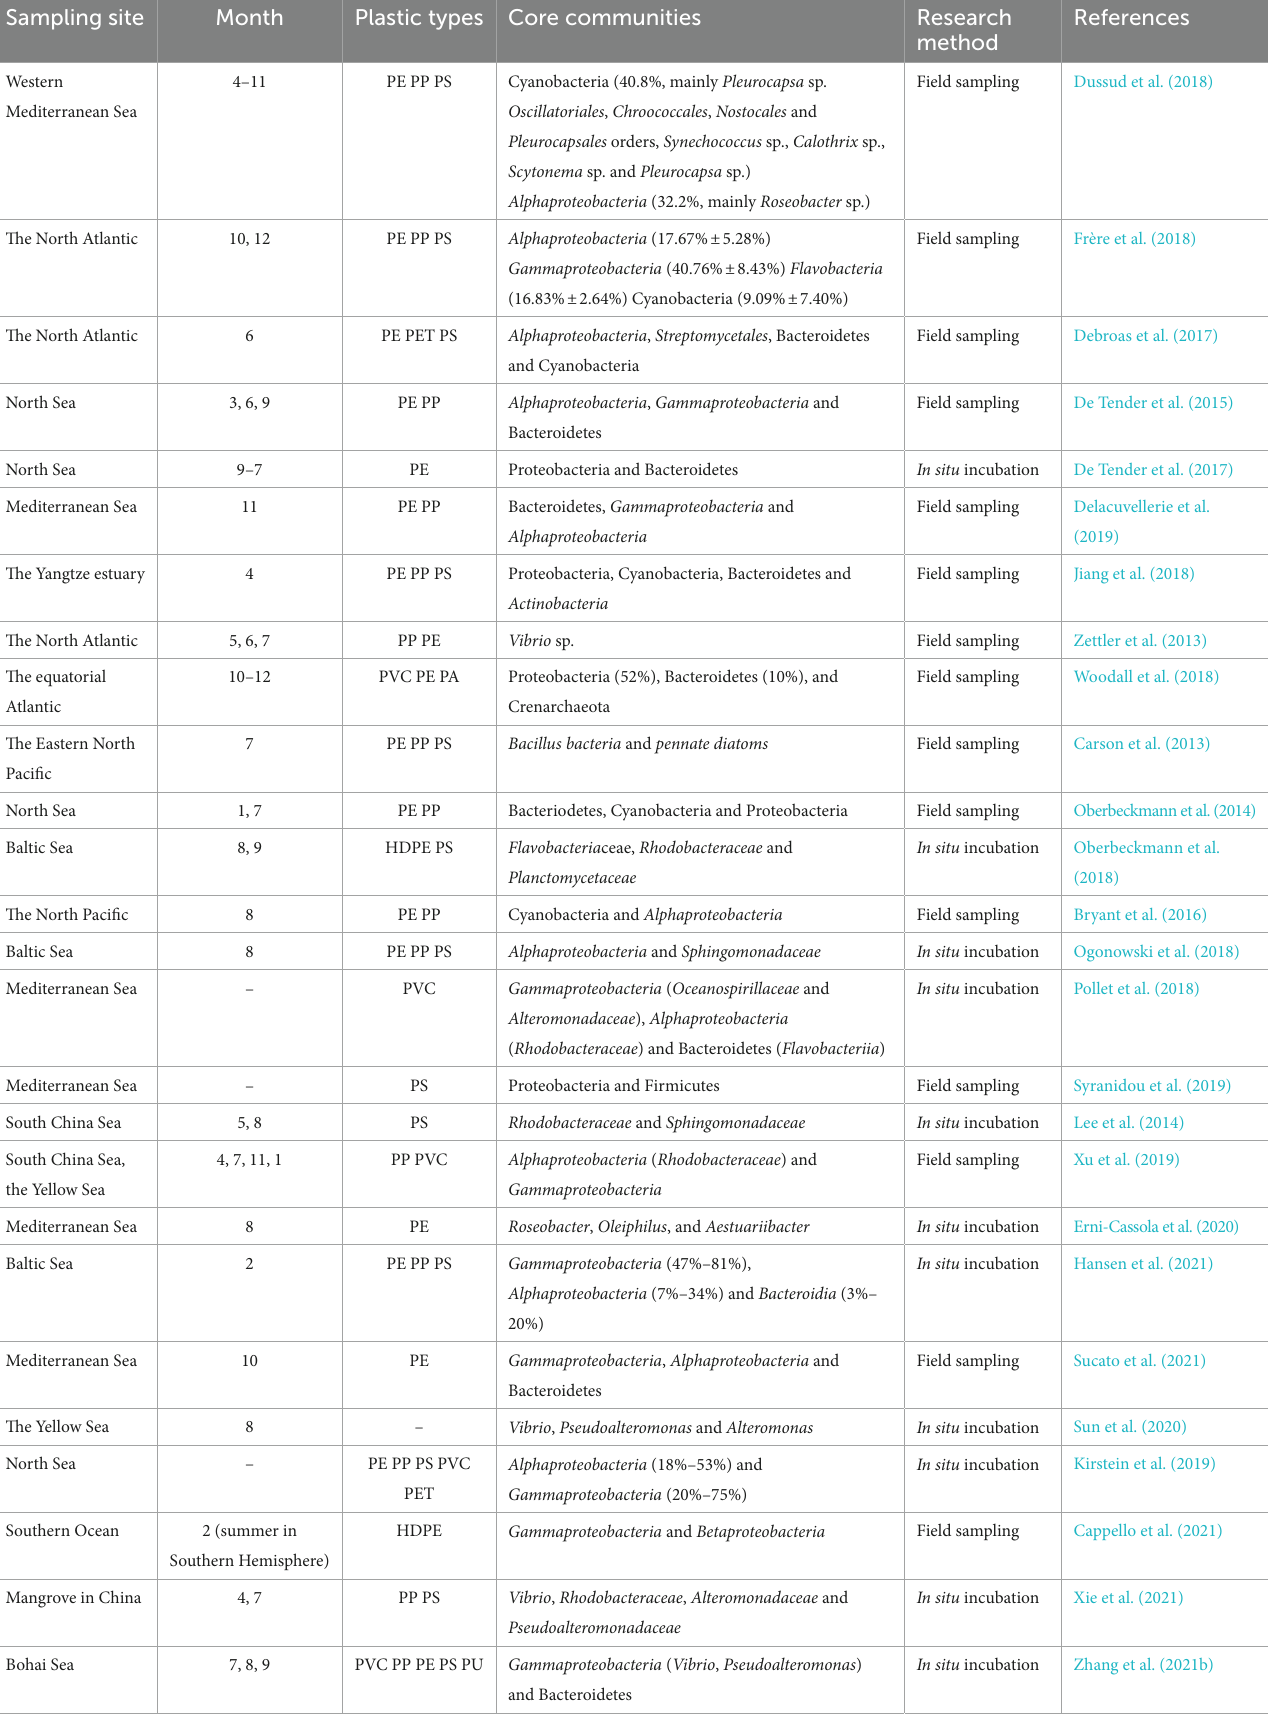
TABLE 1 Studies on the plastisphere based on sampling site and time, plastic type and microbial